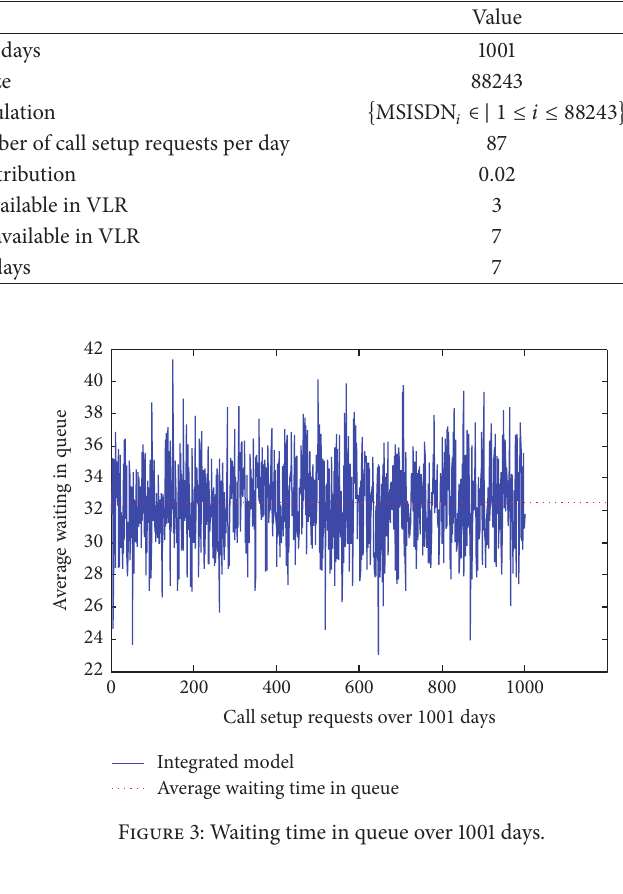
Table 1: Simulation parameters.